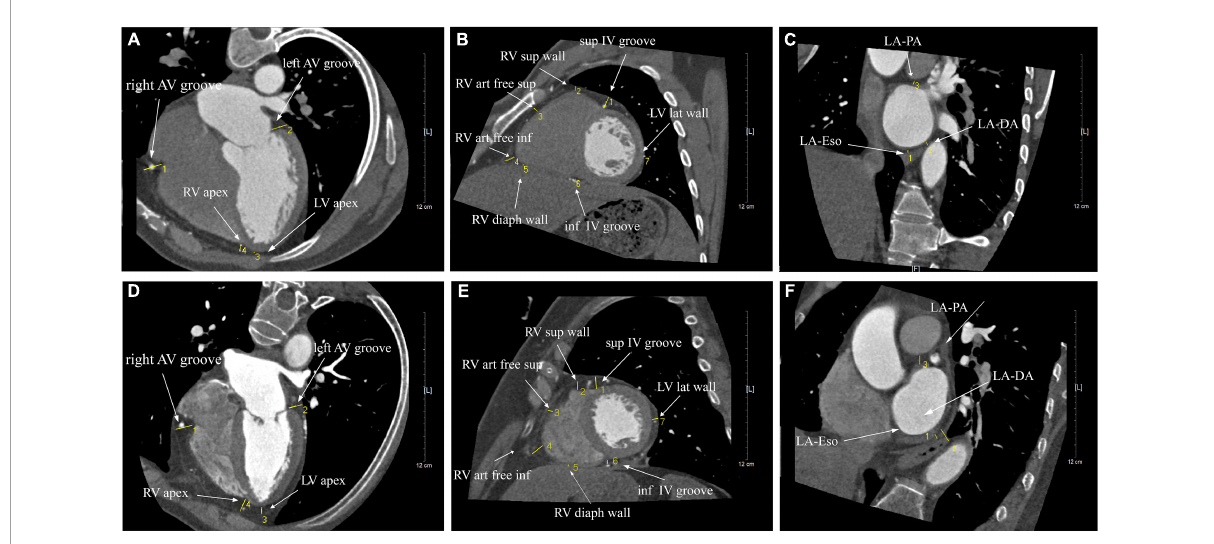
FIGURE2 The illustration of the thickness of EAT surrounding the heart in patients with sinus rhythm (A–C) and AF (E,F) . Cardiac CT images were measured in three different views, including the parasternal short-axis view (A,D) , the horizontal long-axis view (B,E) , and the short-axis view (C,F) .